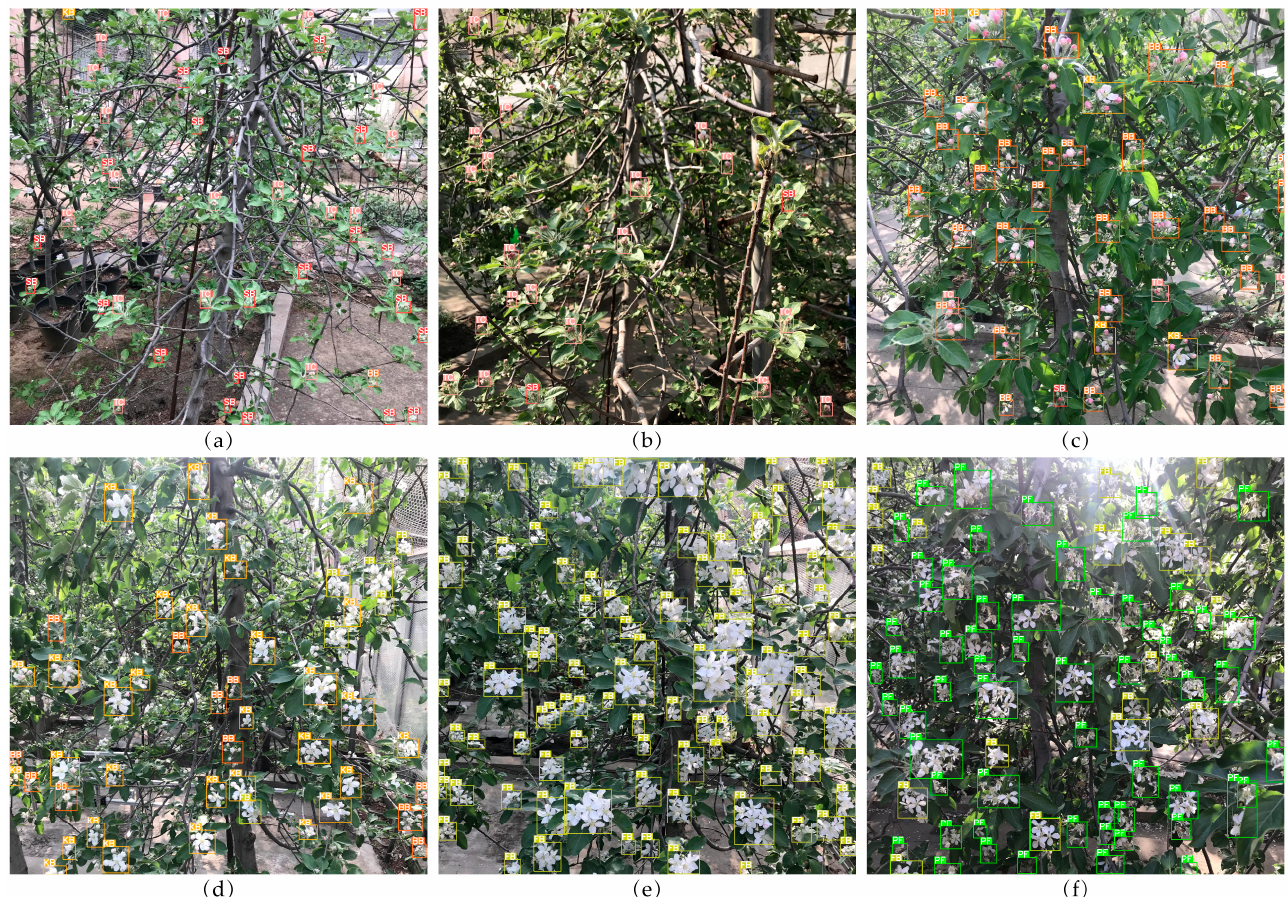
Figure 10. Results of model detection of apple flowers at each blooming level under higher light intensity conditions. ( a ) Spitting Buds; ( b ) Tight Clusters; ( c ) Balloon Blossom; ( d ) King Bloom; ( e ) Full Bloom; ( f ) Petal Fall.